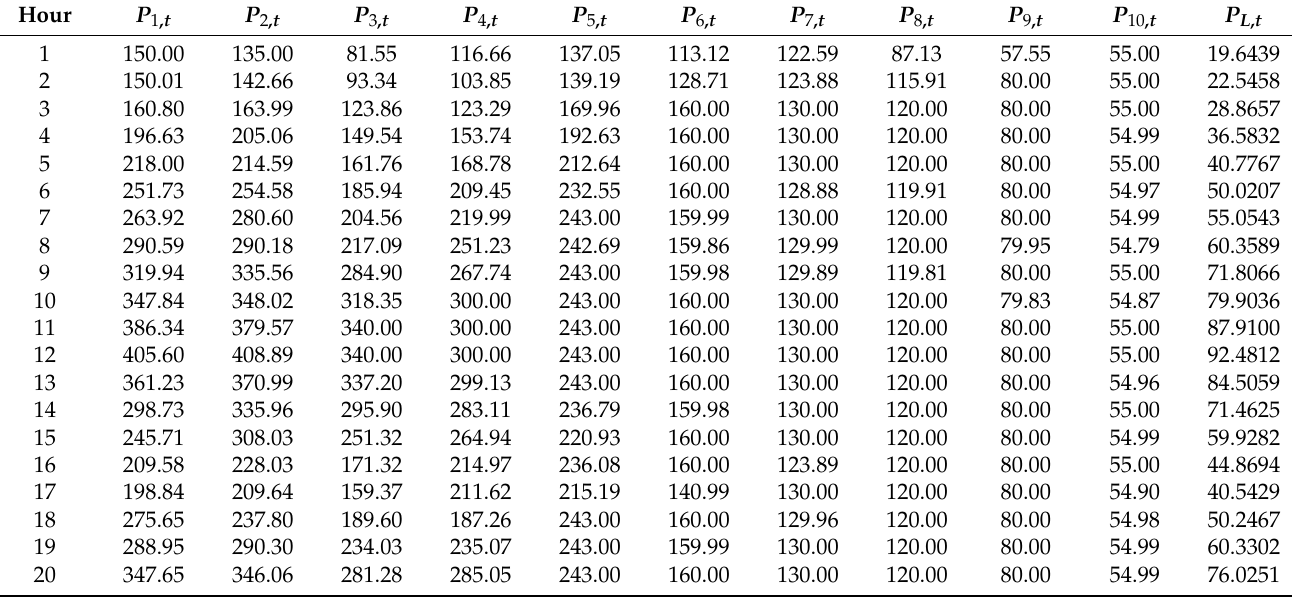
Table 7. Dynamic emission dispatch for case